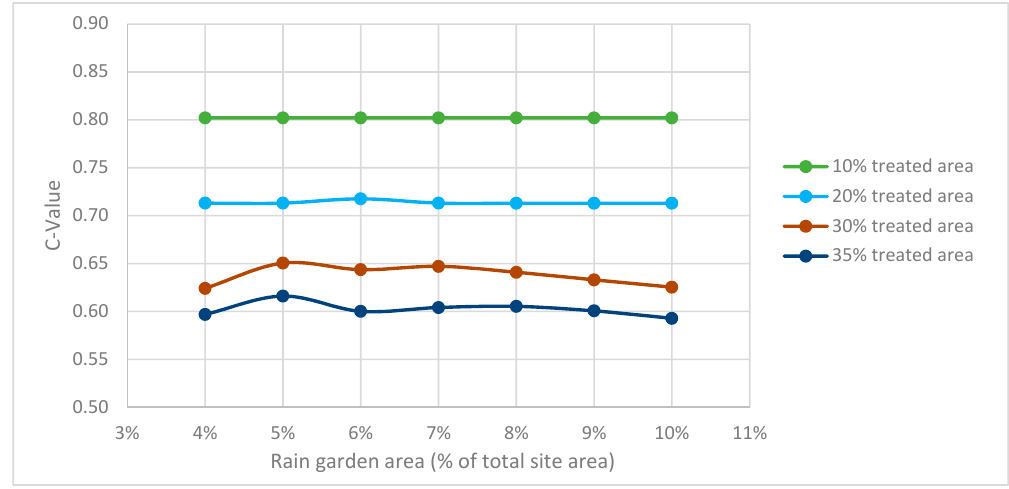
Figure A9. Mixed precinct plot of effective runoff coefficient versus rain garden size for treated catchment areas of 10–35%.